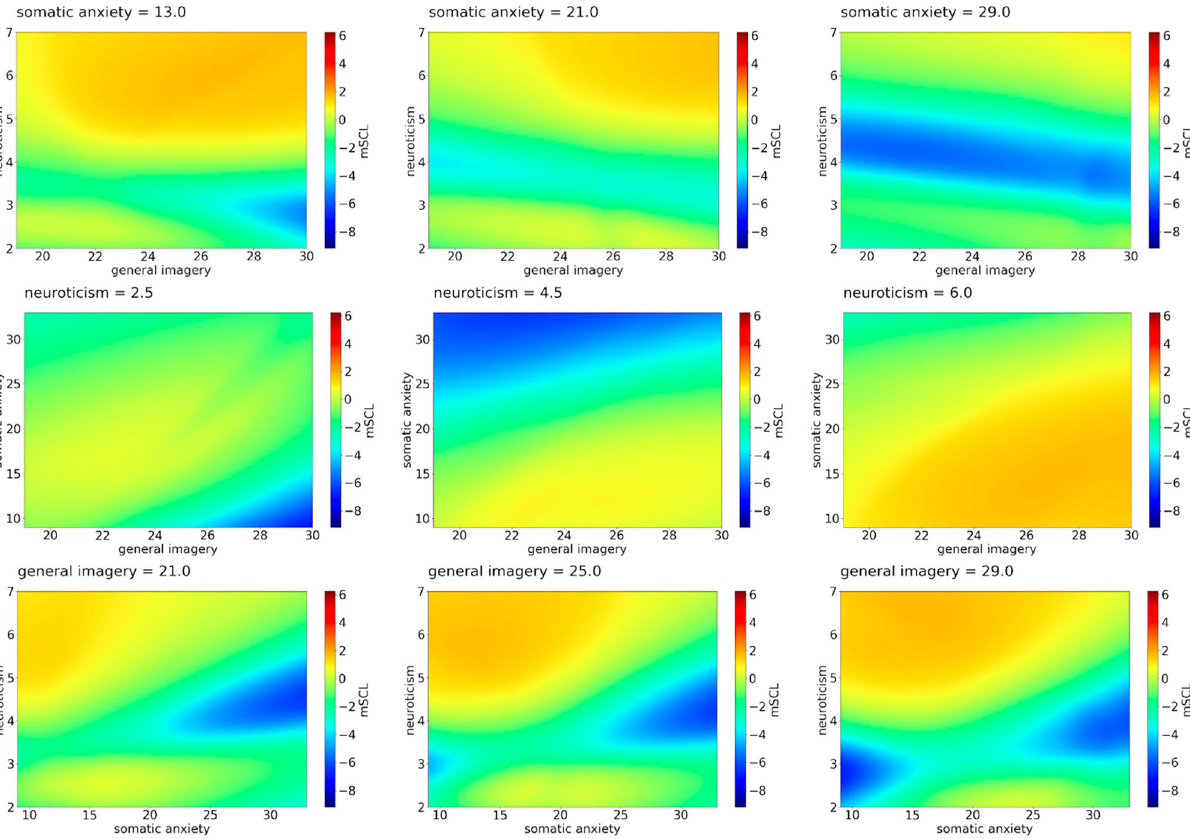
Figure 1. mSCL as a function of psychological features—example predictions of Model 1. First row: mSCL as a function of general imagery and neuroticism for three values of somatic anxiety . Second row: mSCL as a function of general imagery and somatic anxiety for three values of neuroticism . Third row: mSCL as a function of somatic anxiety and neuroticism for three values of general imagery . Three chosen values of somatic anxiety, neuroticism, and general imagery represent the middle points of each tercile of these